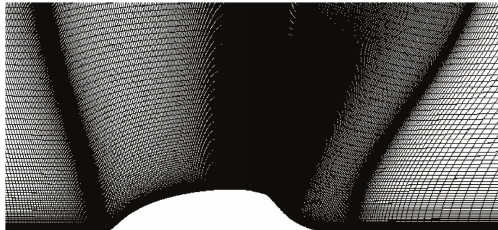
Figure 3: Computational grid for wall-mounted Hump (note: every fifth point is shown).